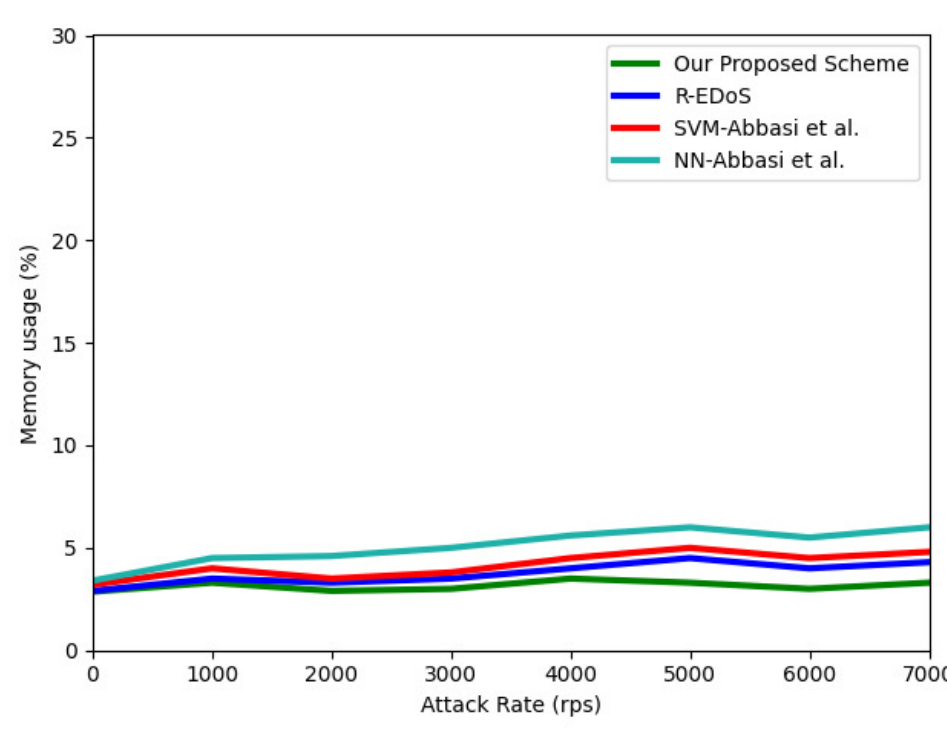
Figure 12. Compute usage according to attack rate.